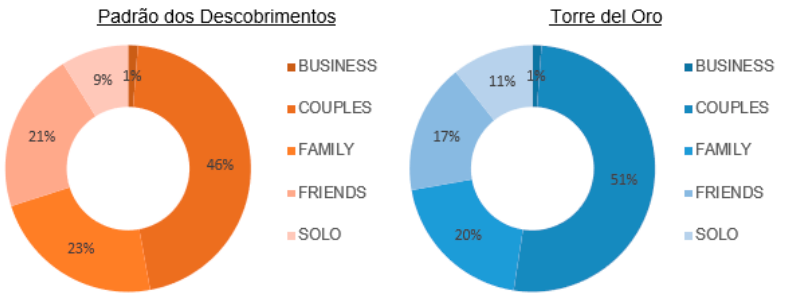
Figure 9. Number of TripAdvisor’s users in relation to their style of travel.